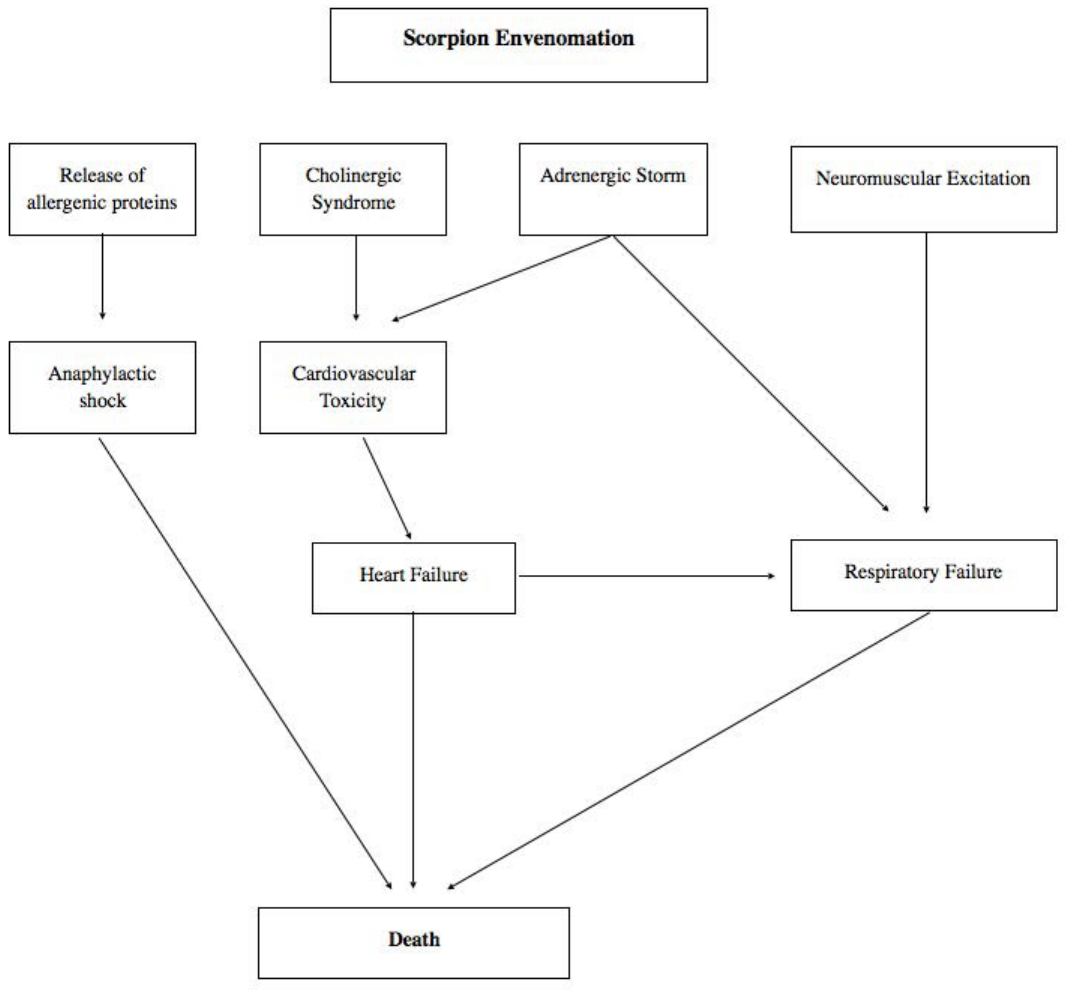
Figure 2. Physiopathological mechanisms leading to scorpion envenomation-related death